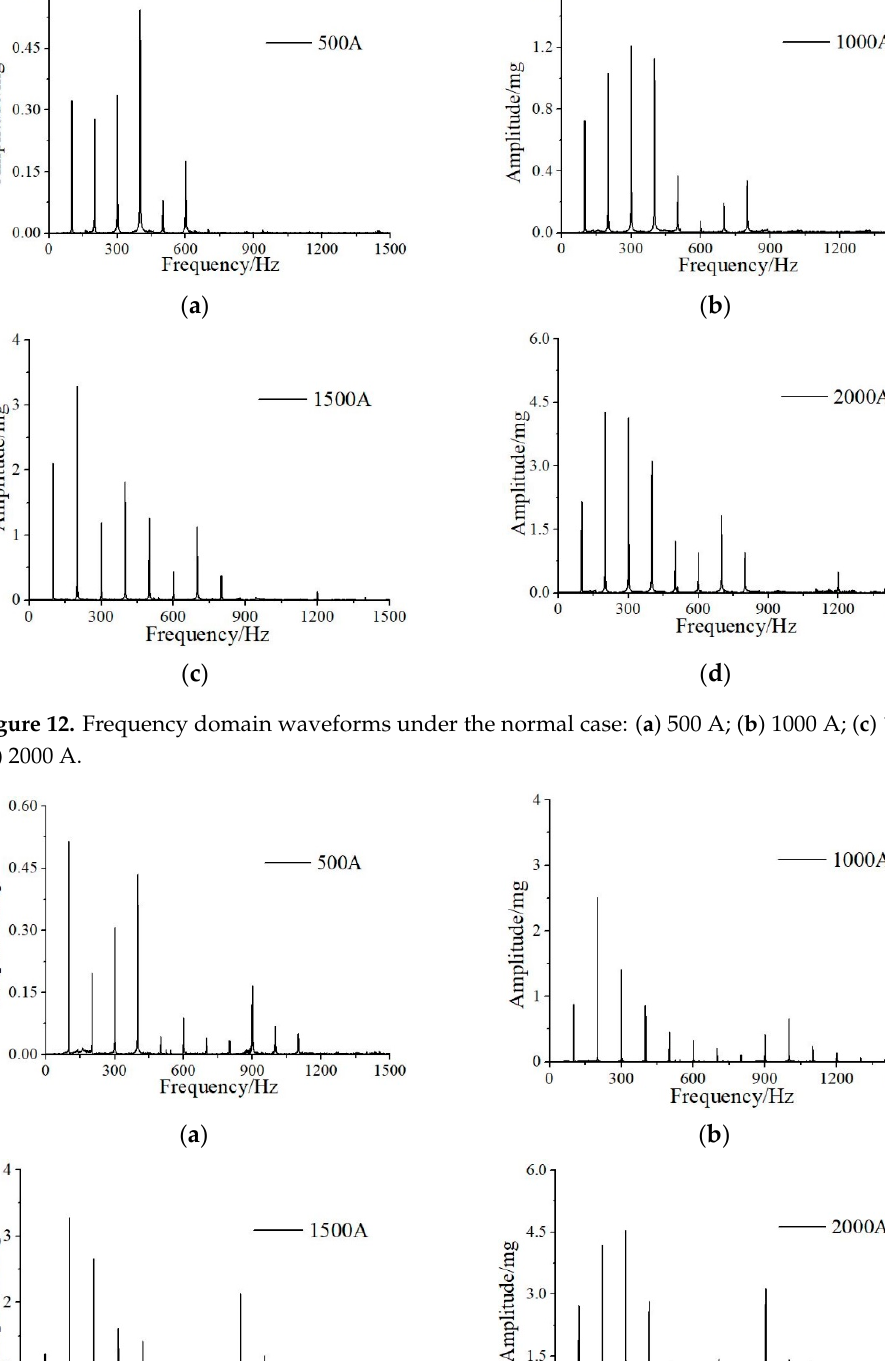
( d ) Figure 14. Frequency domain waveforms under the serious poor contact case: ( a ) 500 A; ( b ) 1000 A; ( c ) 1500 A; ( d ) 2000 A. To summarize, when the contact condition deteriorates, the frequency spectrum range becomes wider, and increased energy is concentrated at higher frequency compo- nents. The amplitude of each frequency component becomes bigger. When the current increases gradually, there are more high frequency components, and the amplitude also becomes bigger. The waveform distortion rate (THD) reflects the distortion degree of a signal wave- form relative to the sinusoidal waveform, which can be used to describe the influence of higher harmonics component on vibration signal waveform [23]. In this paper, THD can be calculated by power spectrum of vibration signal, as shown in Equations (20)–(24). In the formulas, v(t) (0 ≤ t ≤ 1 s) represents vibration signal, τ refers to displacement variable (0 ≤ τ ≤ 1 s), F( τ ) denotes the autocorrelation function of v(t) and P(f) refers to power spec- trum.